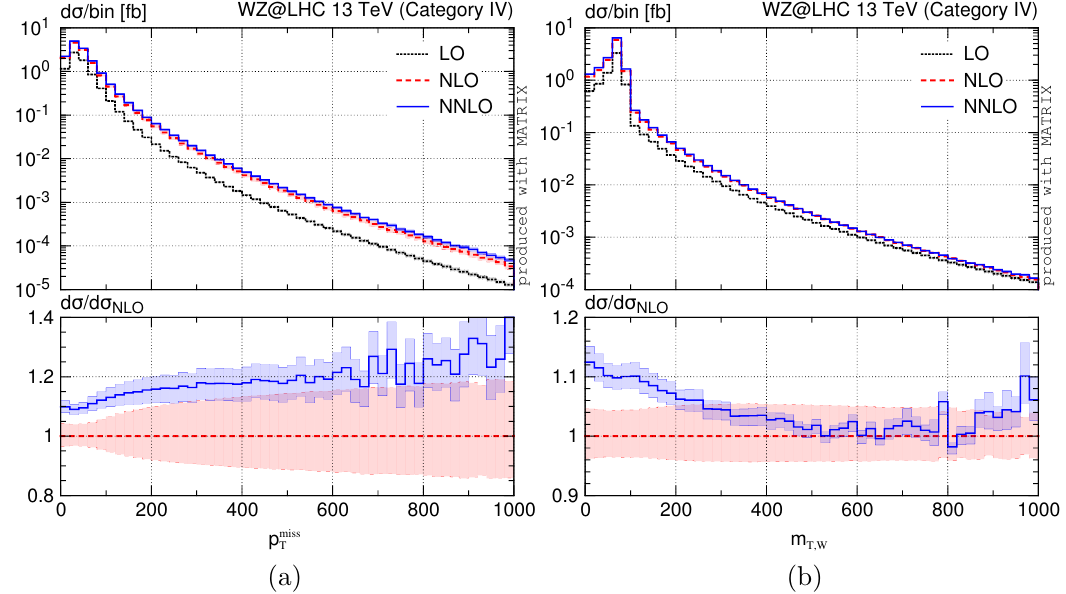
Figure 18 . Distributions with respect to (a) p miss an additional m ‘‘ > 105 GeV cut (Category